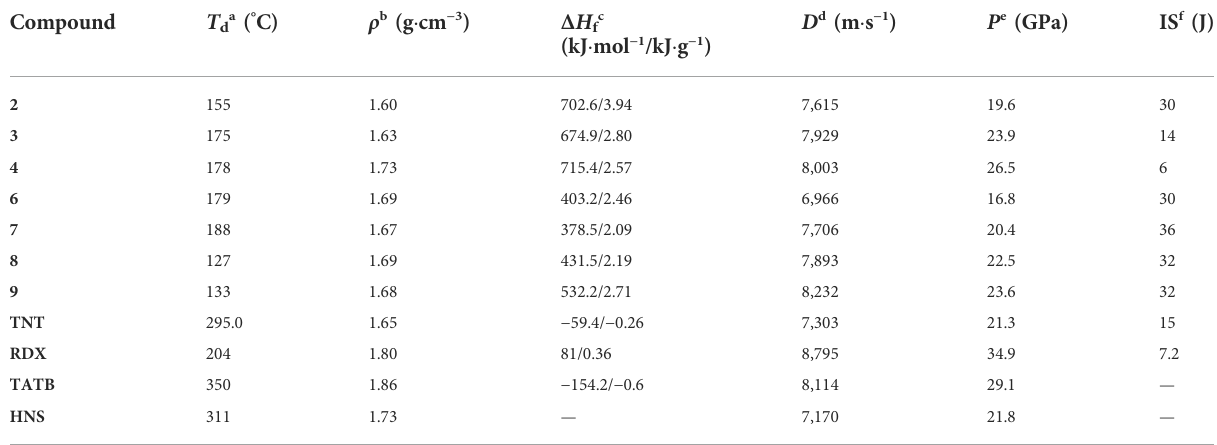
TABLE 2 Physical properties of obtained 2 – 4 and 6 –